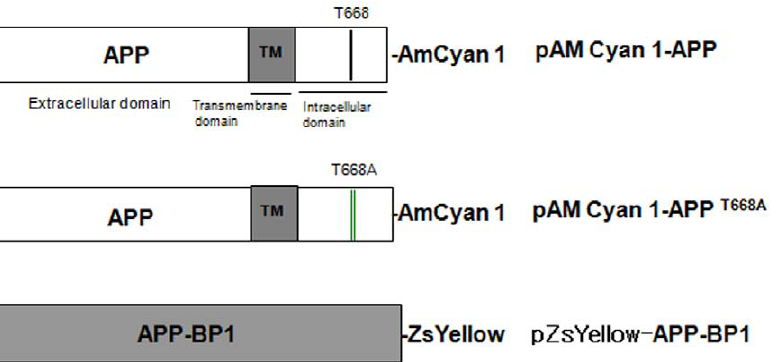
Figure 7. A list of DNA constructs used in FRET experiments. A list of DNA constructs used in FRET study (Figures 8–10) was shown.